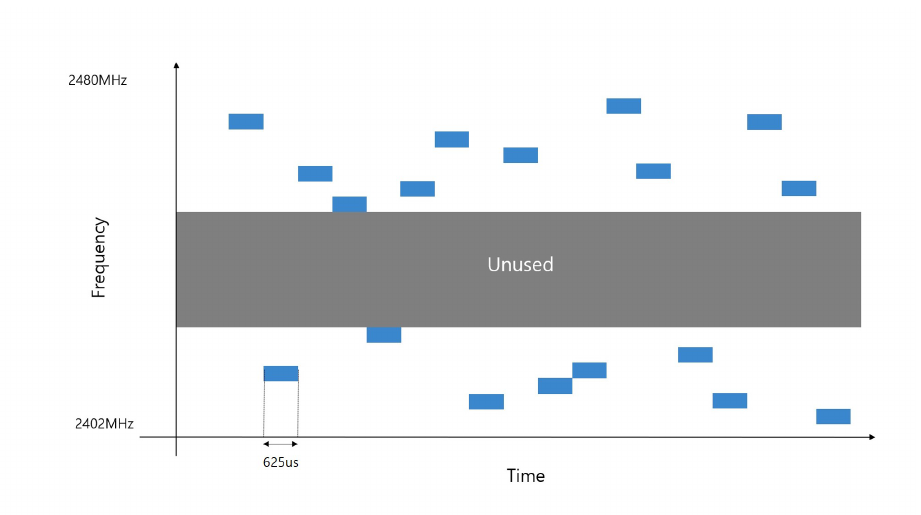
Figure 1. An example of Adaptive Frequency Hopping (AFH)